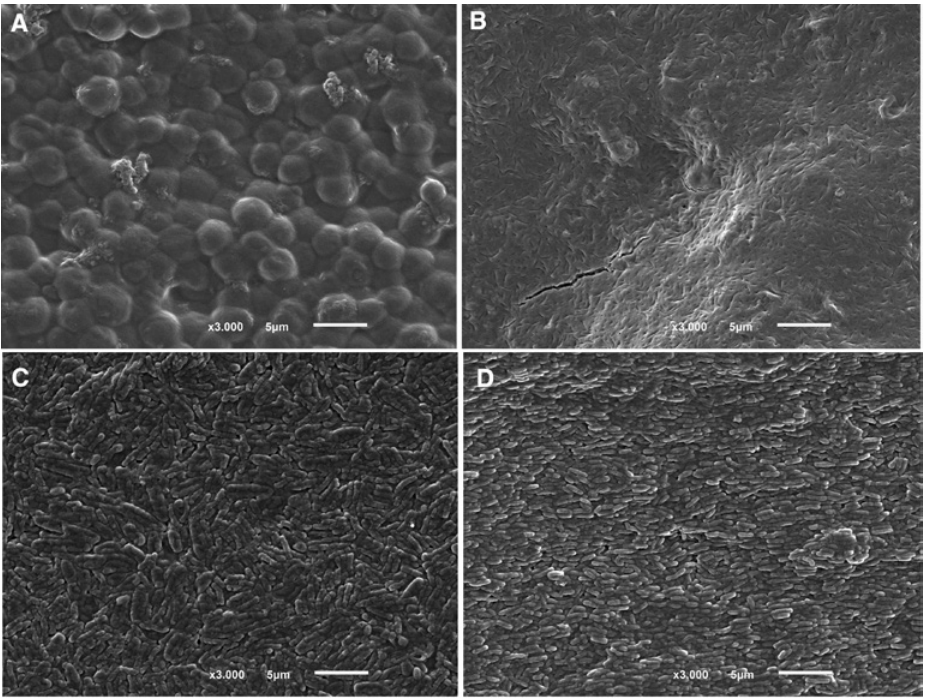
Figure 9: Scanning electron microscopy (SEM) analysis of biosorbents before and after biosorption of Cd(II) ions: Rhodotorula sp. (A) before, (B) after; Bacillus megaterium (C) before, (D)